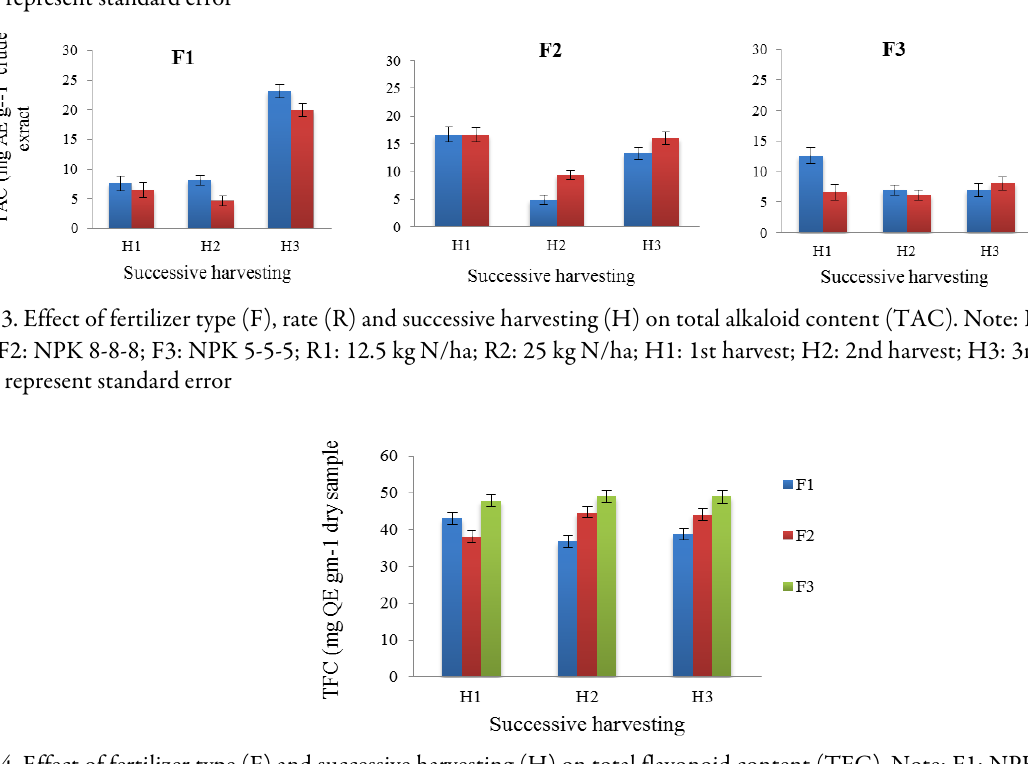
Fig. 2. Effect of fertilizer type (F), rate (R) and successive harvesting (H) on total saponin content (TSC). Note: F1: NPK 15-15- 15; F2: NPK 8-8-8; F3: NPK 5-5-5; R1: 12.5 kg N/ha; R2: 25 kg N/ha; H1: 1 st harvest; H2: 2 nd harvest; H3: 3 rd harvest. Error bars represent standard error